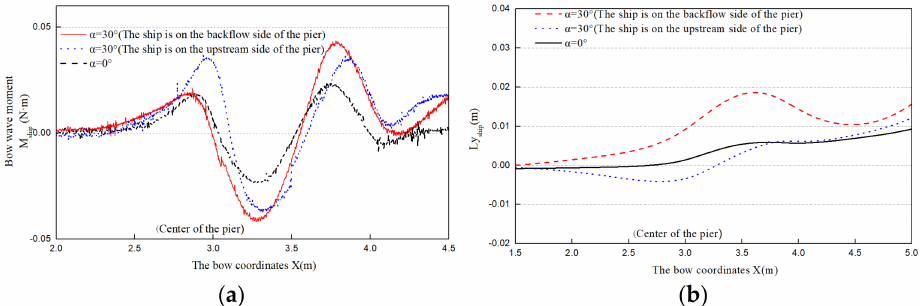
Figure 29. Change laws of the bow roll moment and center of gravity position on both sides of the circular-ended pier α = 30 ◦ : ( a ) Bow roll moment; ( b ) Center of gravity